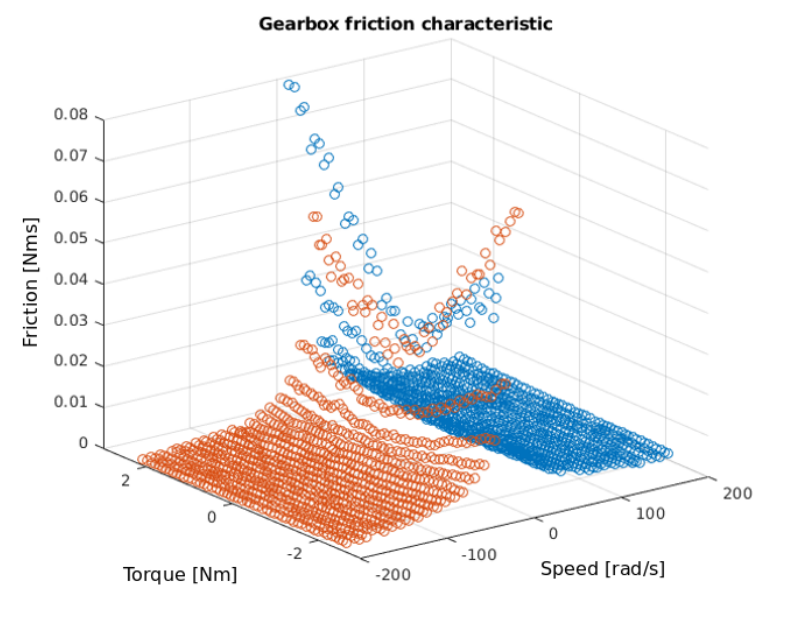
Figure 5. Four-quadrant visualisation of friction points of the gearbox, obtained by experimental measurement (input shaft